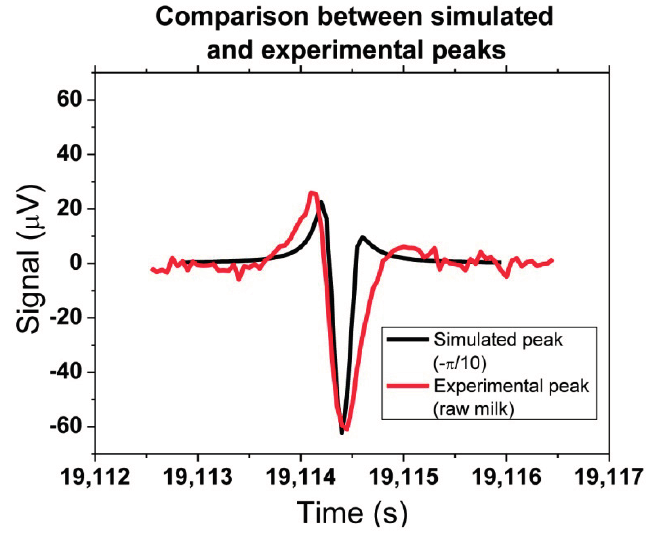
Figure 25. Direct comparison of experimental and simulated peaks. The simulation considered two S treptococcus agalactiae cells flowing at 50 μ L/min, with a rotation of the magnetization by an angle of −π /10 with respect to the